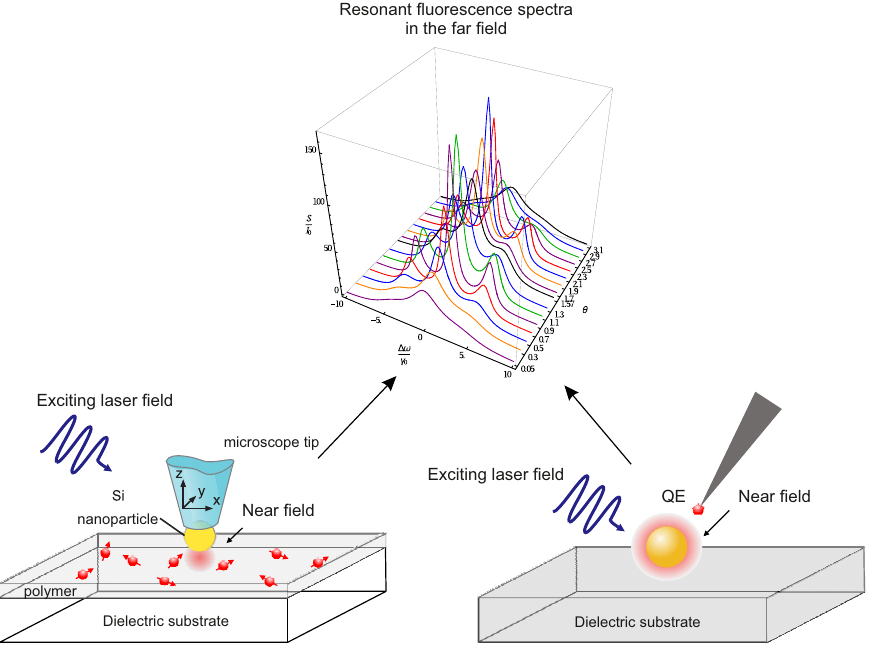
Figure 16. Schemes of two possible experiments on measuring the parameters (intensity and polar- ization) of the near field of an NP from the registration of the resonance fluorescence spectrum of a QE that interacts with the NP in the far